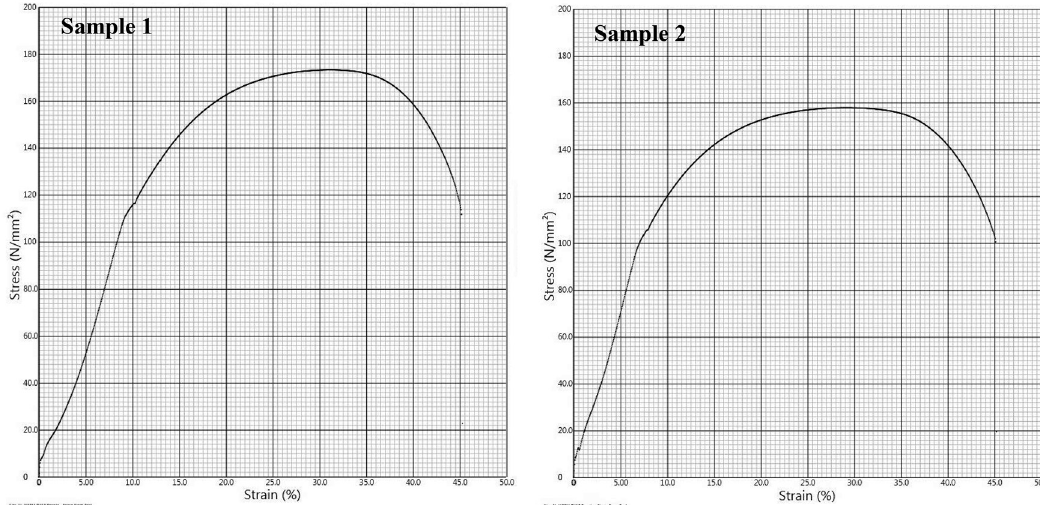
Figure 6: Stress – strain plot for the tensile specimen taken from the failure zone.